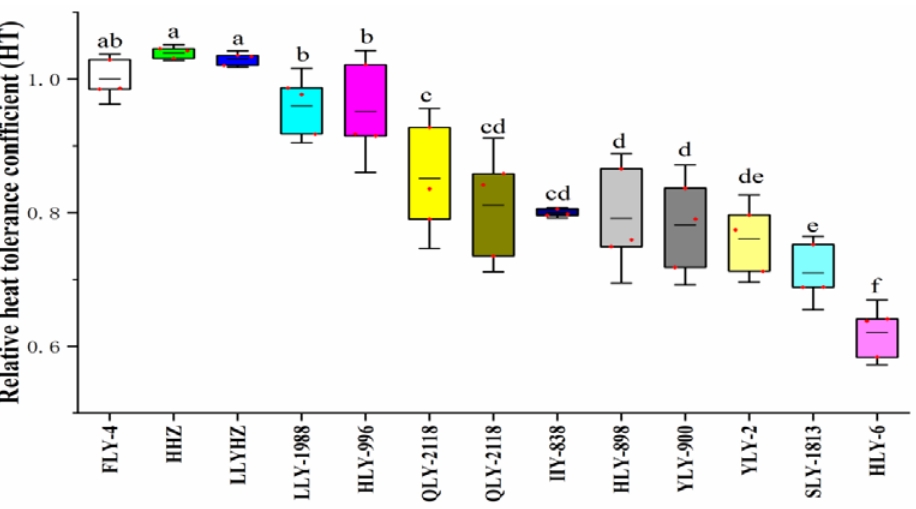
Figure 5. Relative heat tolerance of different varieties. Error bars are the standard deviation (±SD) of three biological replicates. Columns with different letters are significantly different (LSD test, p < 0.05). Error bars are the standard deviation (±SD) of three biological replicates.